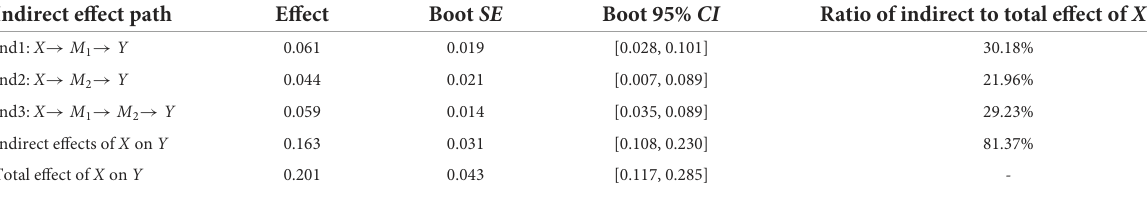
TABLE 4 Results of sequential mediation analysis.